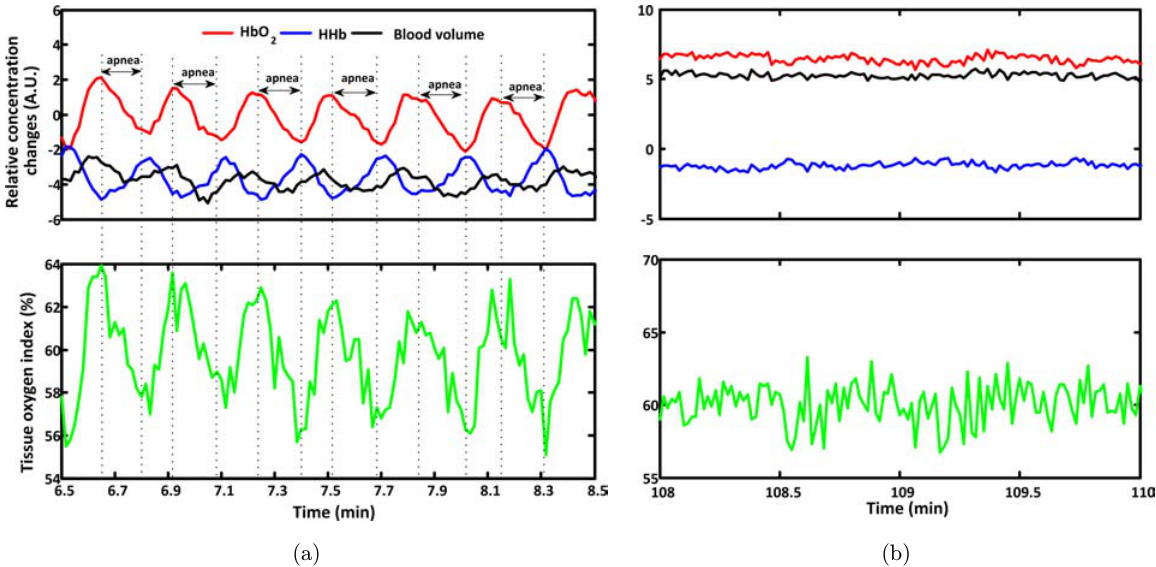
Fig. 1. Typical fragments of cerebral hemodynamics during baseline measurements (a) and optimal CPAP pressures (b) measured from Subject 1. The apnea events are marked by dash lines and double arrows shown in (a). BV, HbO 2 and HHb changes are expressed in arbitrary units (A.U.), as the mean value of ¯rst 60-s measurements was set at 0. During apnea events shown in (a), the BV, HbO 2 and tissue oxygen index signals show parallel decrease that are opposite to the HHb which increases after the initiation of apnea. Then an increase of BV, HbO 2 and tissue oxygen index, while a decrease of HHb appears after the termination of apnea. These apnea associated periodic oscillations in hemodynamic parameters are totally eliminated under optimal CPAP pressures, as shown in (b).